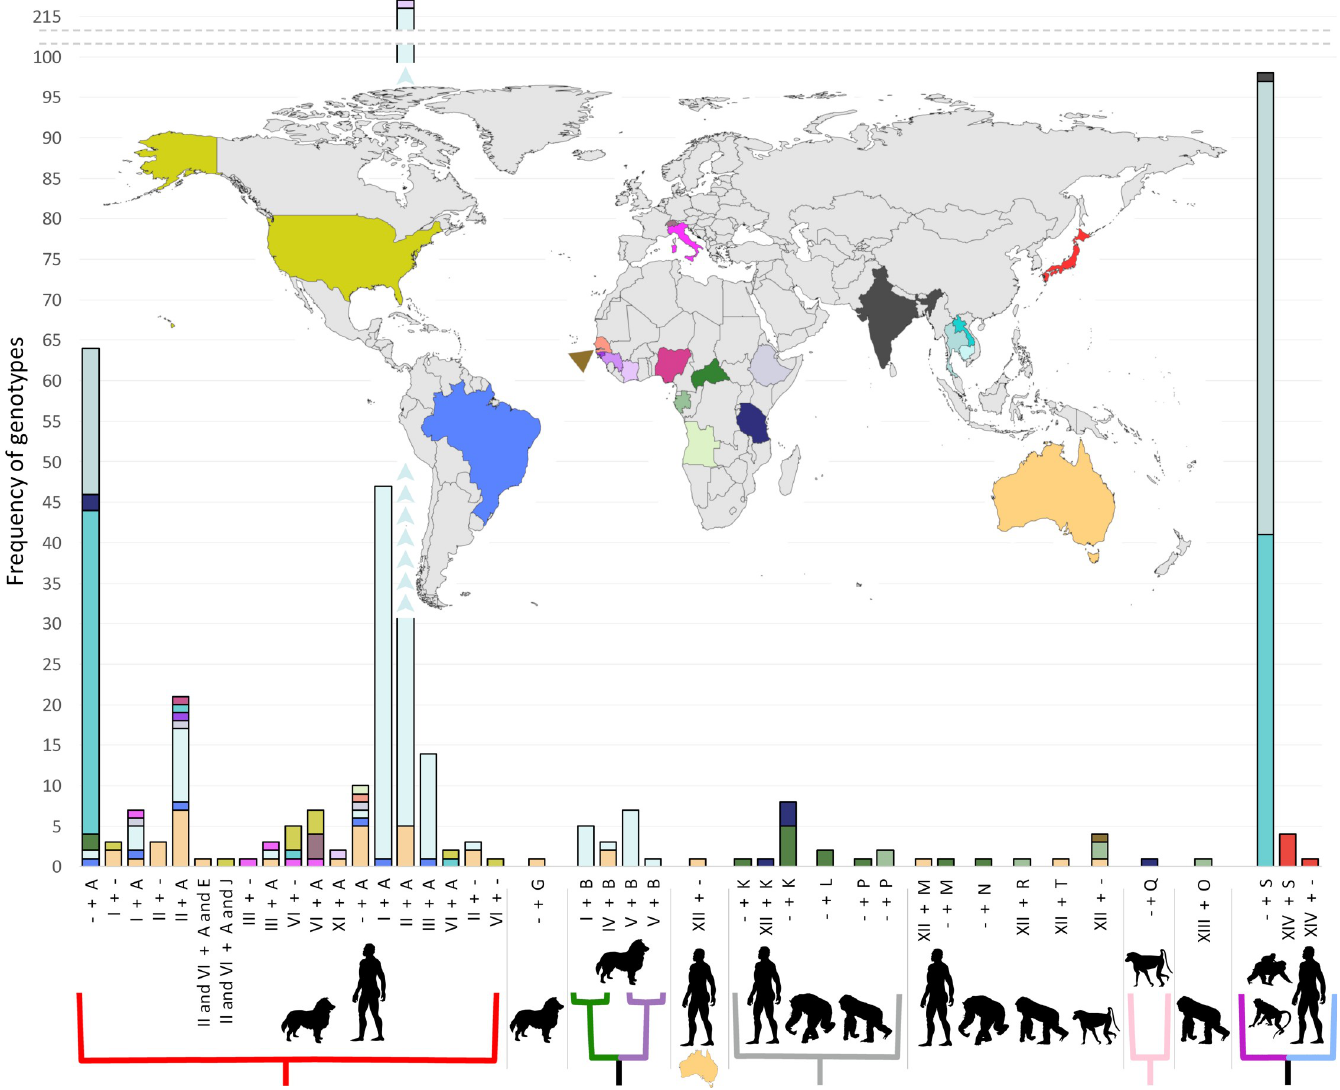
Fig 3. Global frequency of Strongyloides spp. 18S genotypes. Histogram bars are colored according to their origin, corresponding to the colors on the map. A dash (-) in the horizontal axis labels indicates a missing 18S haplotype (either HVR-I or HVR-IV). The colored branches below the horizontal axis correspond to the colored branches in Fig 2, where red represents S . stercoralis types infecting both dogs and humans (lineage A), the green/purple clade represents S . stercoralis types infecting only dogs (lineage B), the gray clade represents S . fuelleborni types from African great apes and humans, the light pink clade represents S . fuelleborni from a baboon and the magenta/light blue clade represents types found in humans and macaques. The absence of a colored branch under a given group indicates that an associated cox1 sequence is presently unavailable for these 18S haplotypes. The miniaturized map of Australia under the horizontal axis represents the type associated with a cox1 sequence that clustered alongside S . fuelleborni from central Africa, yet is sufficiently distinct to be considered unique. https://doi.org/10.1371/journal.pntd.0007609.g003 star), and another that clustered nearest to the Strongyloides sp. “loris” group (Fig 2, dog with black circle) identified by Frias et al. [27]. Makouloutou et al. [28] generated S . fuelleborni sequences from Western lowland gorillas ( Gorilla gorilla ) and chimpanzees ( Pan troglodytes ) whilst performing a study on Oesophagostomum sp. in Gabon (Table 5). Giang et al. (2017) [29] used GenBank sequences generated from Japanese Macaques ( Macaca fuscata ) living at high altitudes to compare to Strongyloides ransomi from Vietnamese pigs. In the first descrip- tion of Strongyloides robustus , Sato et al. [30] refer to a reference sequence from S . f . fuelleborni